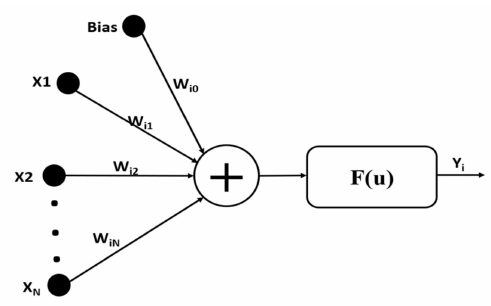
Figure 3. The simple neuron operation in ANN, where “X” represents the input data, “W” represents the weights, ”F” is the activation function and “Yi” is the output.